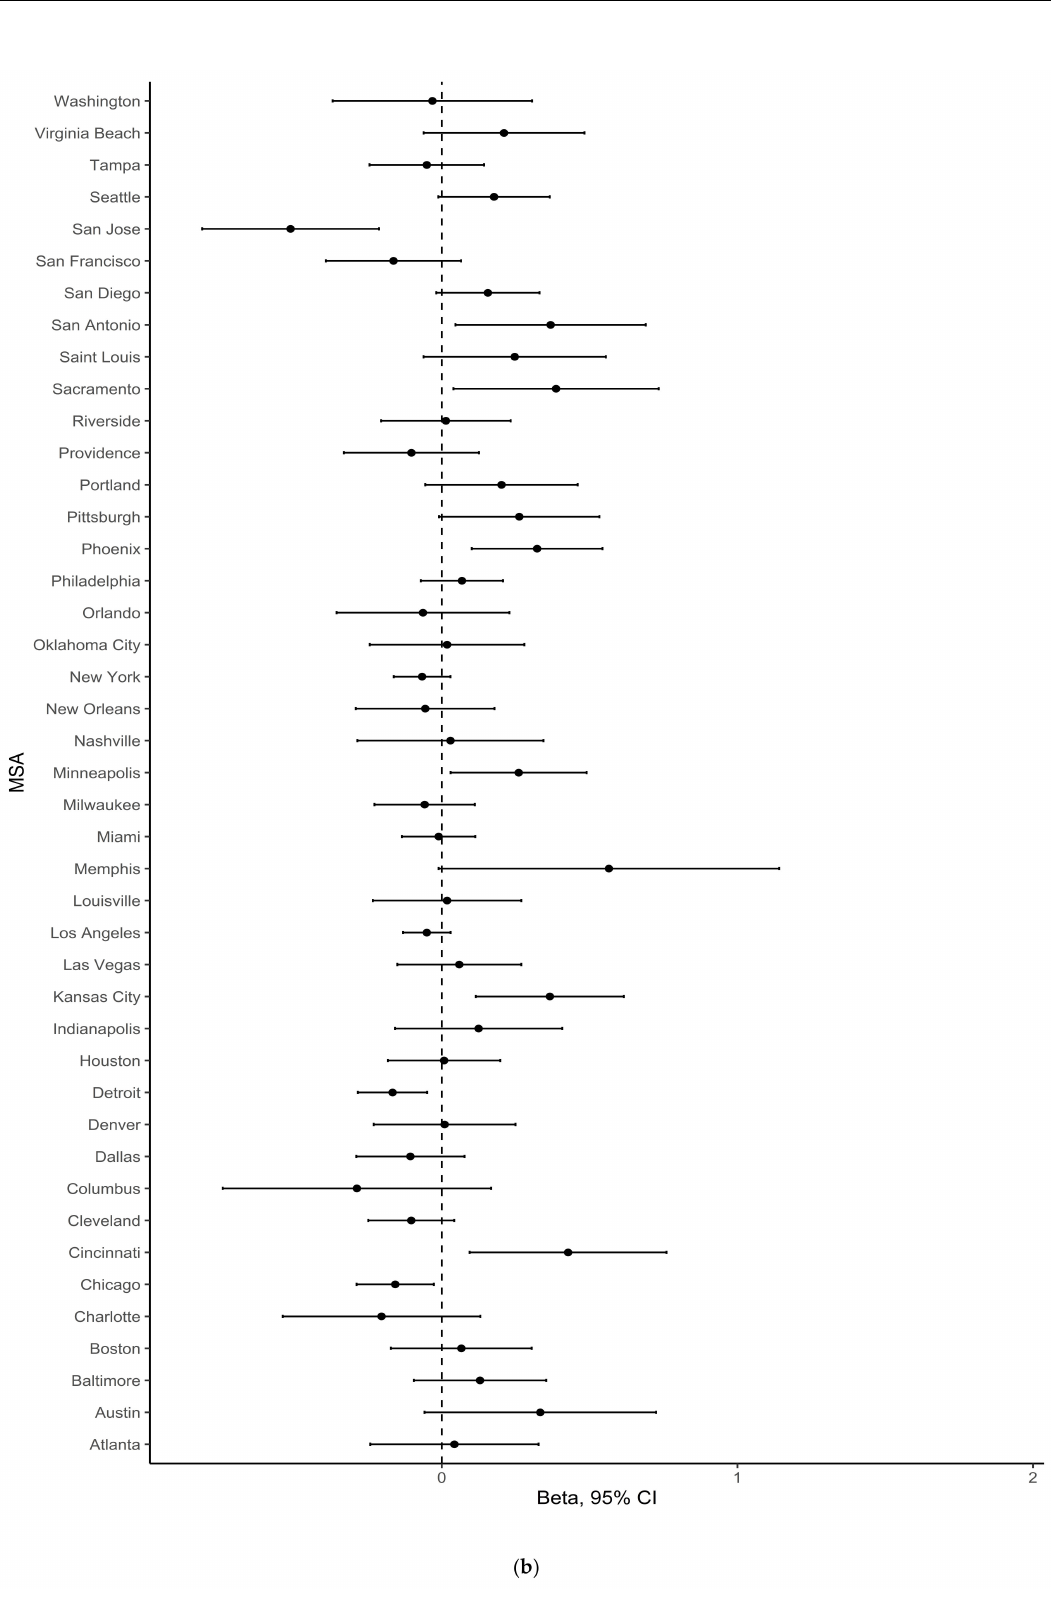
Figure 4. MSA-specific estimates of association between percentage greenspace and changes in household income, adjusted for population density, for the periods ( a ) 1990–2000 or ( b ) 2000–2010. Estimates for the 1990–2000 period represent comparisons of census tracts with percentage greenspace > 75th percentile vs. ≤ 50th percentile for their MSA. Estimates for the 2000–2010 period represent comparisons of census tracts with percentage greenspace > 75th percentile vs. ≤ 75th percentile for their